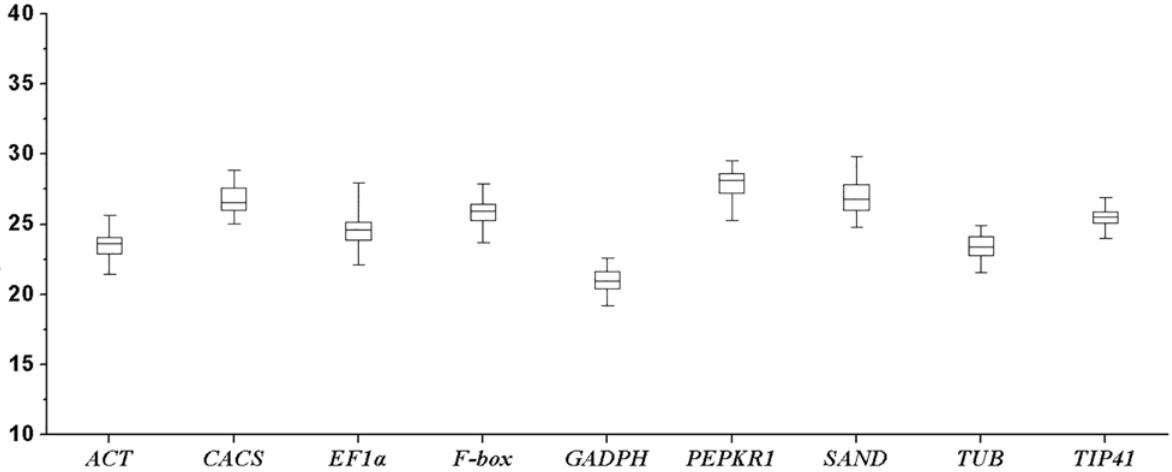
Fig 2. The quantification cycle (Cq) values of the candidate reference genes across all samples under four abiotic stresses. Lines across the Box- plot graph of Cq value represent the median values. Lower and upper boxes show the 25 th percentile to the 75 th percentile. Whiskers represent the maximum and minimum